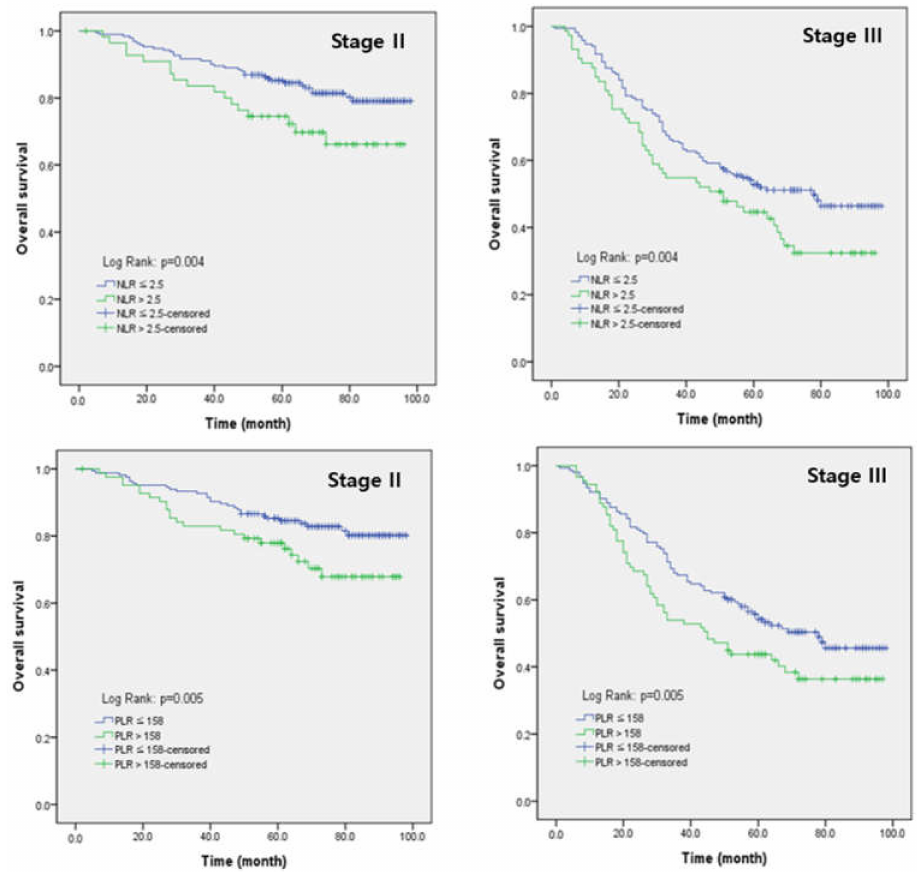
Figure 2. Kaplan–Meier analysis for comparison of overall survival (OS) according to NLR and PLR stratified by TNM